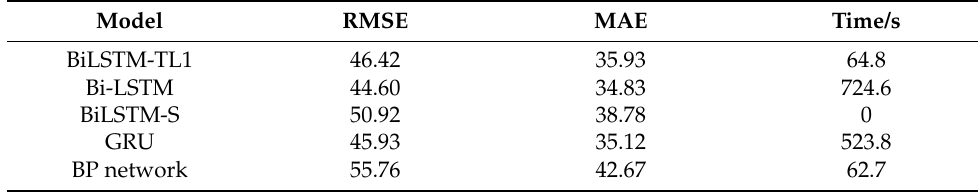
Table 10. Comparison of prediction errors in target